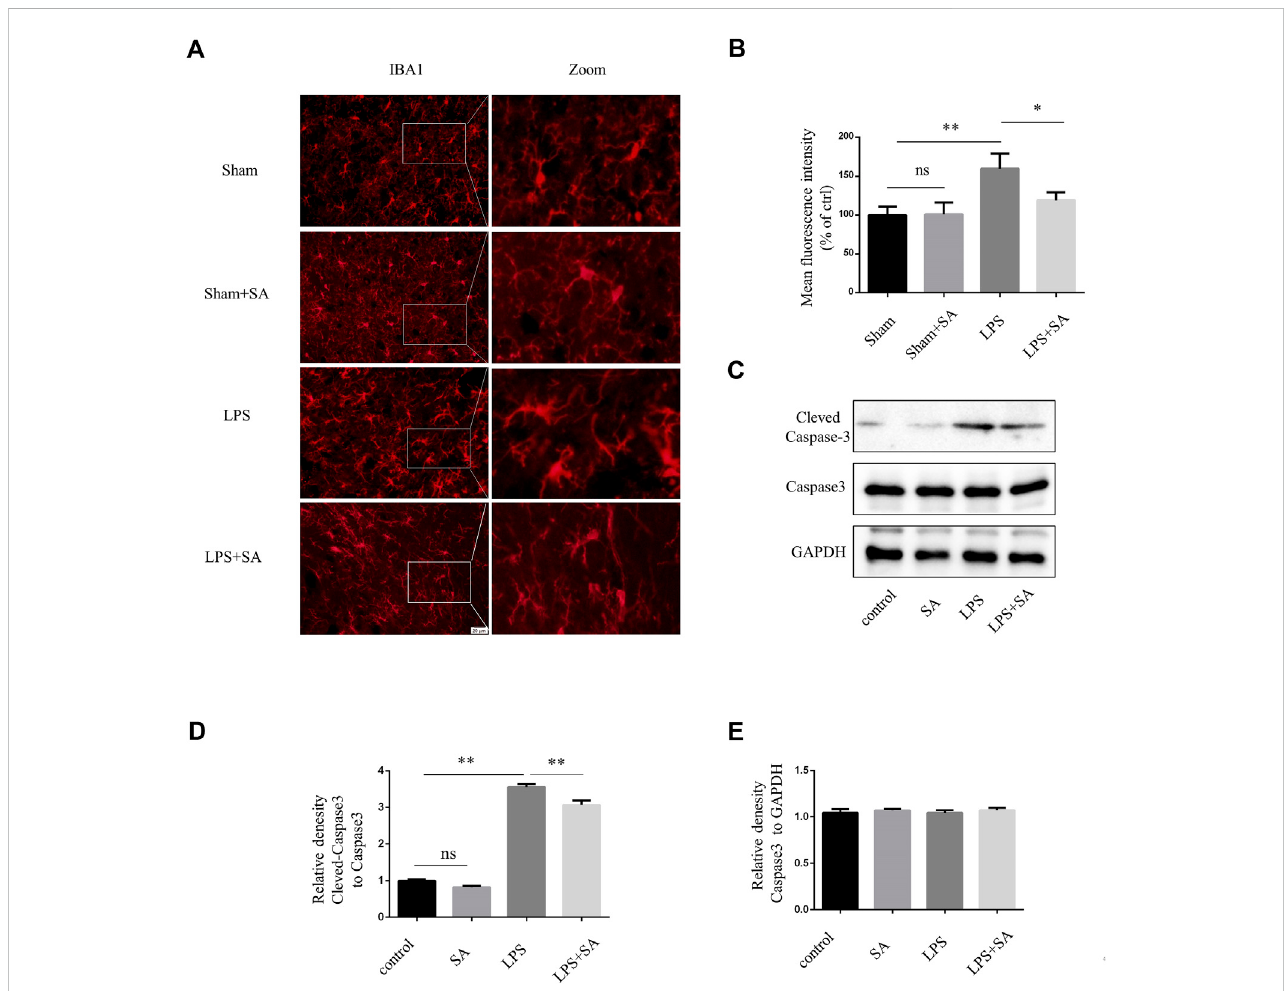
FIGURE 4 SA inhibited LPS-induced microglial activation in vivo and exerts neuroprotective effects. (A) Mice were stereotaxically injected with 2 μ L LPS (1 mg/mL) into the ventricles, followed by SA (1 mg/kg) once a day for seven consecutive days. The brains were cut into brain slices and stained by antibody IBA1. (B) Statistical plot of IBA1 fl uorescence intensity. (C – E) Caspase3 and Cleved-caspase3 were extracted from SH-SY5Y cells and detected by western blot assay. Date are presented as mean ± SD,* p < 0.05, ** p < 0.01, n = 3 per group. Scale bar, 20 µm. Coronal